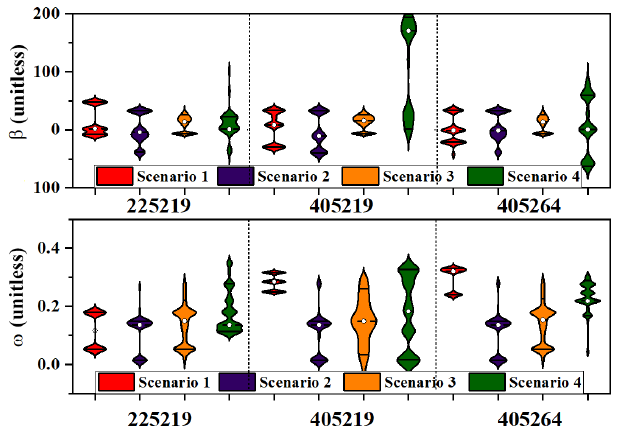
Figure 8. Posterior distributions of the regression parameters ( β and ω ) for the production storage capacity ( θ 1 ) for the four model sce- narios in each catchment when calibrated in the wet years and ver- ified in the dry years. The solid horizontal lines within the violin plots denote the 25th and 75th percentiles of the posterior distribu- tion, while the white dots denote median estimates.